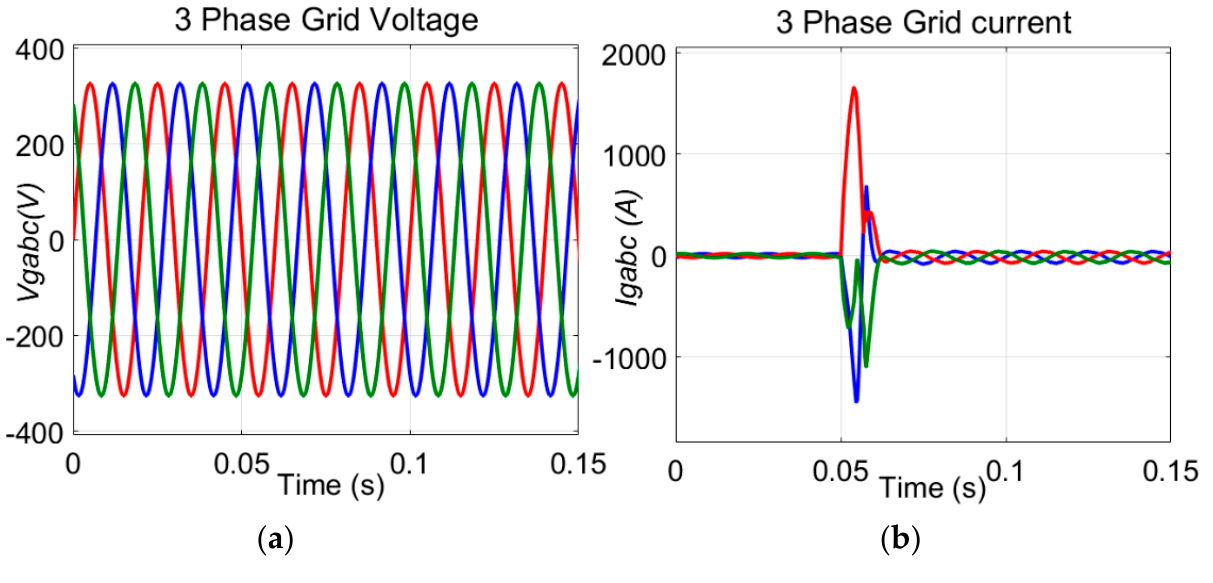
Figure 8. ( a ) Grid voltage. ( b ) Grid current.